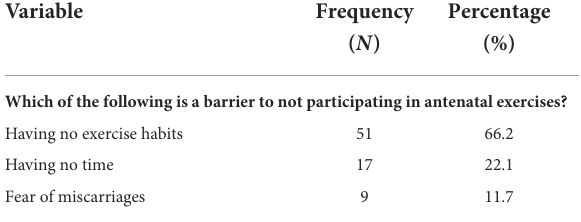
TABLE 9 Responses on barriers to participating in antenatal exercises ( n = 77).